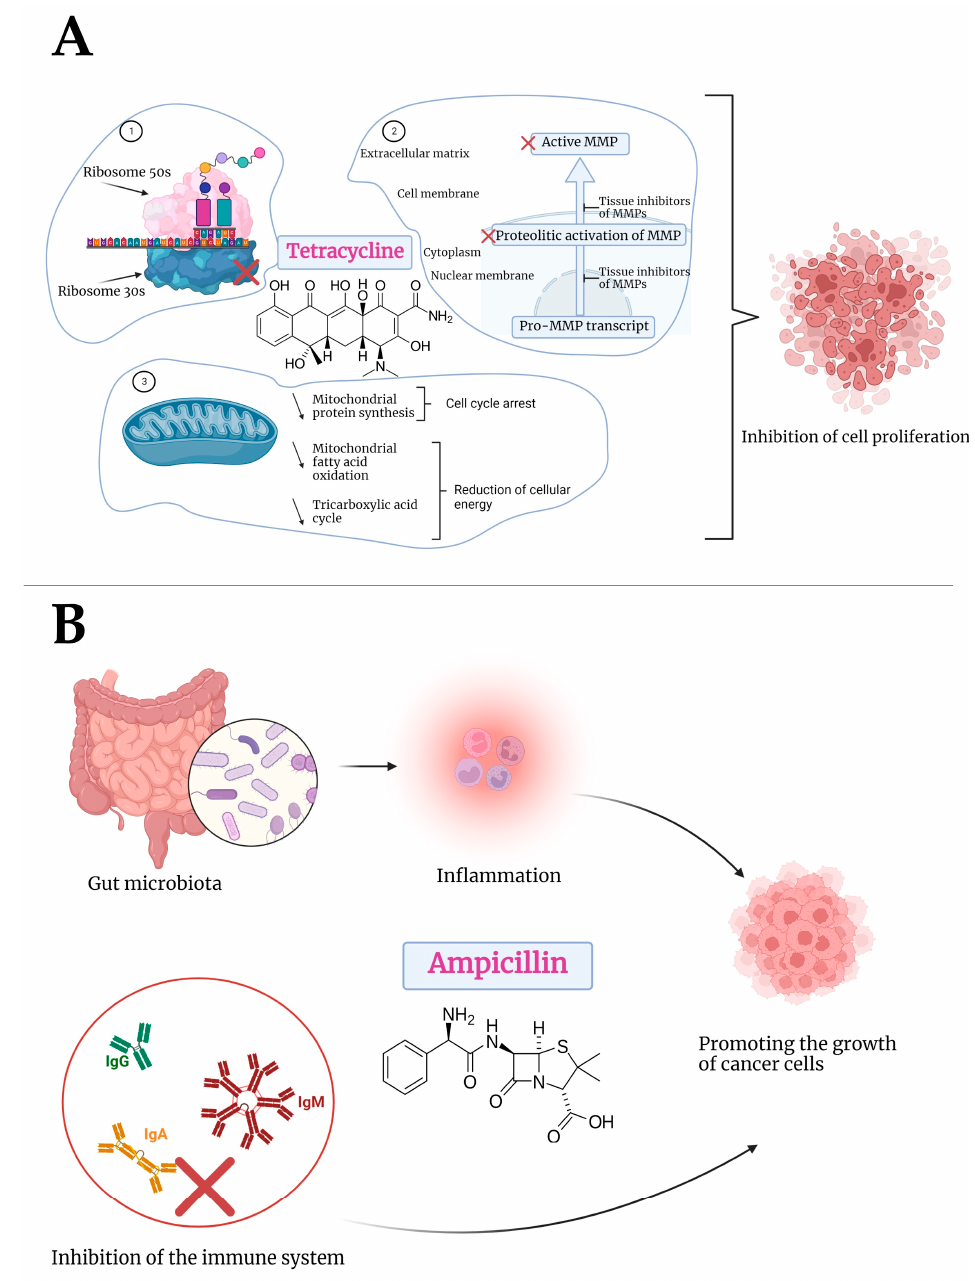
Figure 8. Schematic representation of the mechanism of action of tetracycline ( A ) and ampicillin ( B ). ( A ) 1. Tetracycline binds to the ribosomal site, thereby blocking the synthesis of proteins. A similar process can be observed in mitochondrial ribosomes, with tetracycline inhibiting mitochondrial protein synthesis. 2. Tetracycline inhibits MMPs by acting at the transcriptional and protein initiation levels, thereby inhibiting cell migration and proliferation as well as cell adhesion. 3. Tetracycline inhibits mitochondrial protein synthesis with energy shortage and cell cycle arrest. The mitochon- drial oxidation of fatty acids decreases at the same time, resulting in the down-regulation of the tricarboxylic acid cycle and a decrease in cellular energy. ( B ) Ampicillin affects the gut microbiota, which leads to systemic inflammation and favors the growth of tumor cells. Additionally, ampicillin affects the immune system by decreasing the level of IgA, IgG, and IgM, resulting in the development and proliferation of tumor cells. Created with BioRender.com (accessed on 8 September